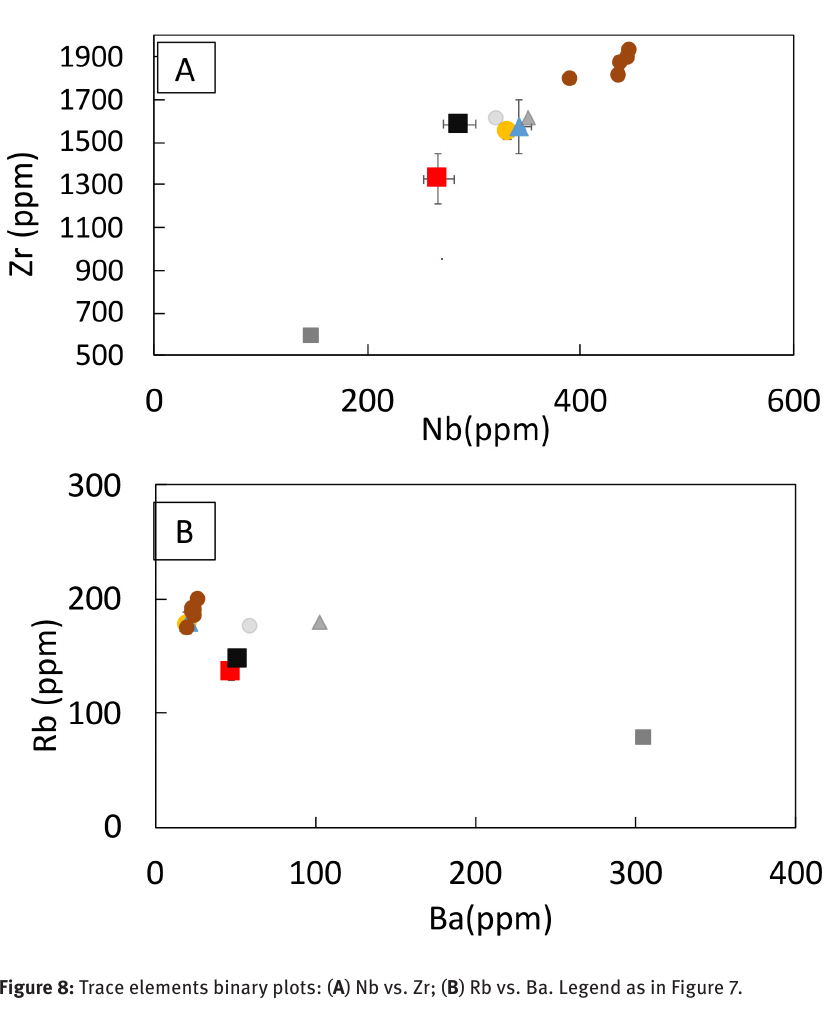
Figure 8: Trace elements binary plots: ( A ) Nb vs. Zr; ( B ) Rb vs. Ba. Legend as in Figure 7.